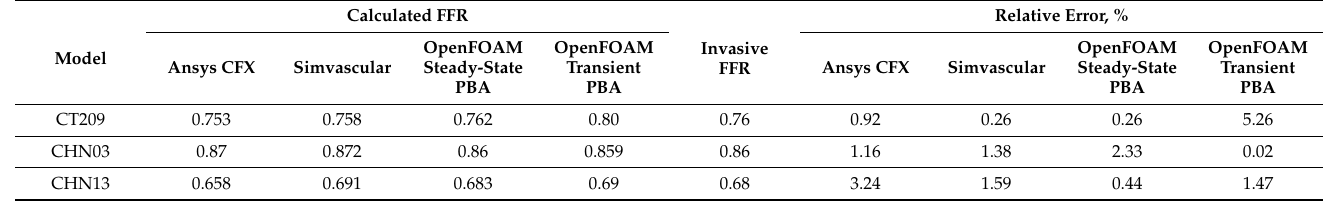
Figure 20. ( a ) FFR distribution with shape of CHN03 transient PBA model and ( b ) PBA residual history. Table 11. Relative errors calculated between the invasive and calculated FFRs using Simvascular, Ansys CFX, and